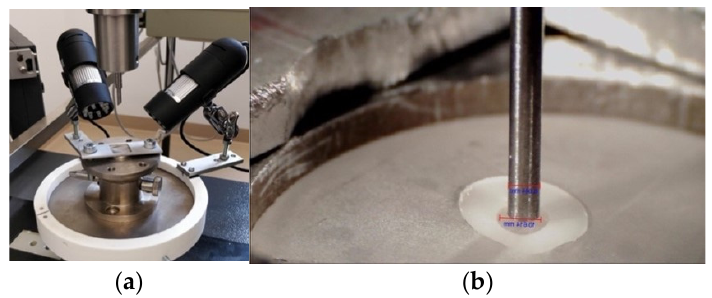
Figure 3. ( a ) Custom-made sample holder with the 2 digital microscopes; ( b ) Piston pressing the post.